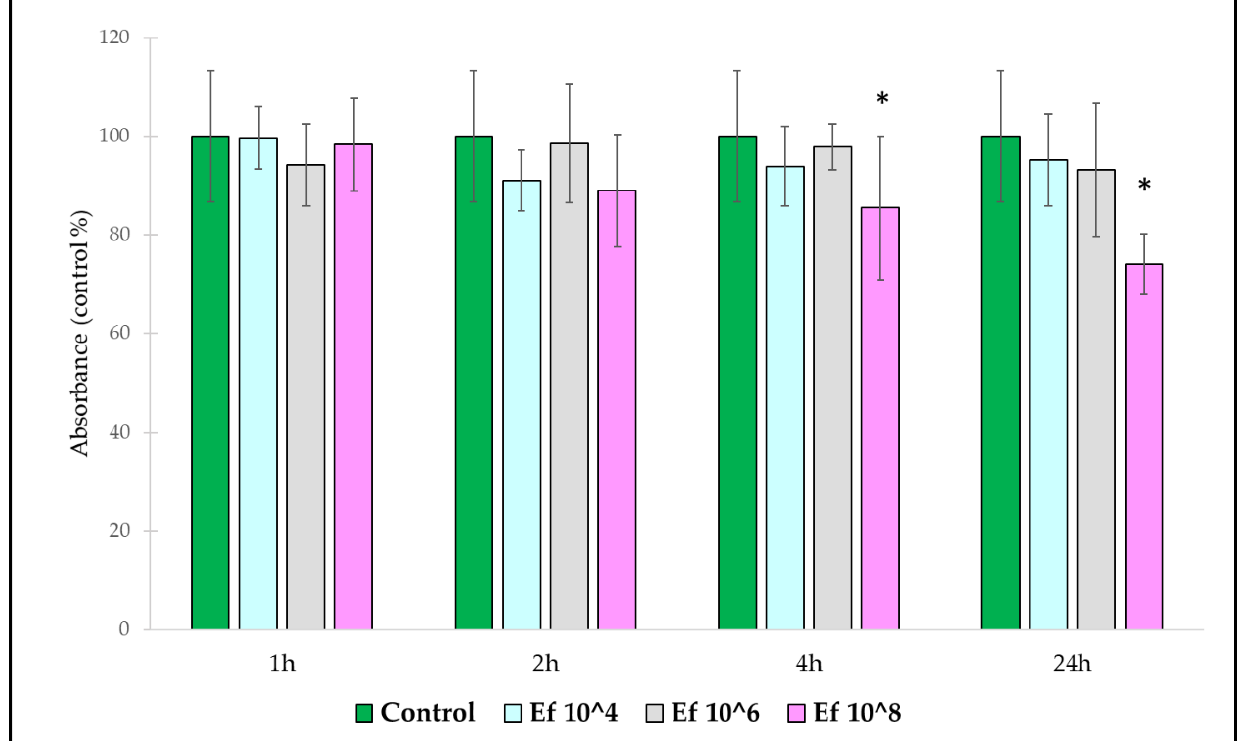
Figure 2. Viability of IPEC-J2 cells after treatment with E. faecium NCIMB 10415 for different times. Control : plain cell culture medium treatment for 1 h; 1 h, Ef 10^4 : treatment for 1 h with E. faecium suspension of 10 4 CFU/mL; 1 h, Ef 10^6 : treatment for 1 h with E. faecium suspension of 10 6 CFU/mL; 1 h, Ef 10^8 :treatment for 1 h with E. faecium suspension of 10 8 CFU/mL; 2 h, Ef 10^4 :treatment for 2 h with E. faecium suspension of 10 4 CFU/mL; 2 h, Ef 10^6 : treatment for 2 h with E. faecium suspension of 10 6 CFU/mL; 2 h, Ef 10^8 : treatment for 2 h with E. faecium suspension of 10 8 CFU/mL; 4 h, Ef 10^4 : treatment for 4 h with E. faecium suspension of 10 4 CFU/mL; 4 h, Ef 10^6 : treatment for 4 h with E. faecium suspension of 10 6 CFU/mL; 4 h, Ef 10^8 : treatment for 4 h with E. faecium suspension of 10 8 CFU/mL; 24 h, Ef 10^4 : treatment for 24 h with E. faecium suspension of 10 4 CFU/mL; 24 h, Ef 10^6 : treatment for 24 h with E. faecium suspension of 10 6 CFU/mL; 24 h, Ef 10^8 : treatment for 24 h with E. faecium suspension of 10 8 CFU/mL. Data are shown as means with standard deviations, n = 6/group. * Indicates significant differences ( p ≤ 0.05) compared to the control. In order to characterize the intracellular redox state of the IPEC-J2 cells, the DCFH-DA method was used. Treatment with S. Typhimurium caused an increase in the fluorescence compared to the control (Figure 3). All three treatment combinations (i.e., pre-treatment, co-treatment and post-treatment with S. Typhimurium and E. faecium in two different concentrations) resulted in a decreased amount of ROS. When IPEC-J2 cells were treated with only E. faecium 10 8 CFU/mL and 10 7 CFU/mL, a decrease in fluorescence could be observed compared to the